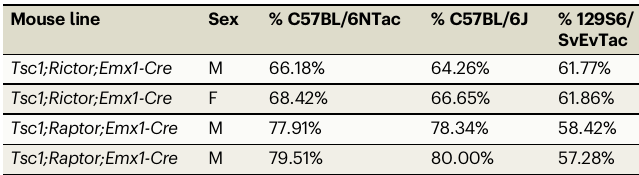
Table 1 | Single Nucleotide Polymorphism (SNP) genetic background testing Mouse